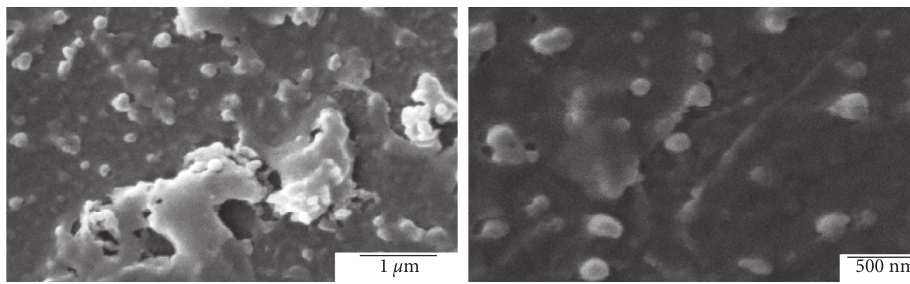
Figure 5: SEM micrographs of palladium NPs exposed to C . vulgaris extract (Arsiya et al. [91]).